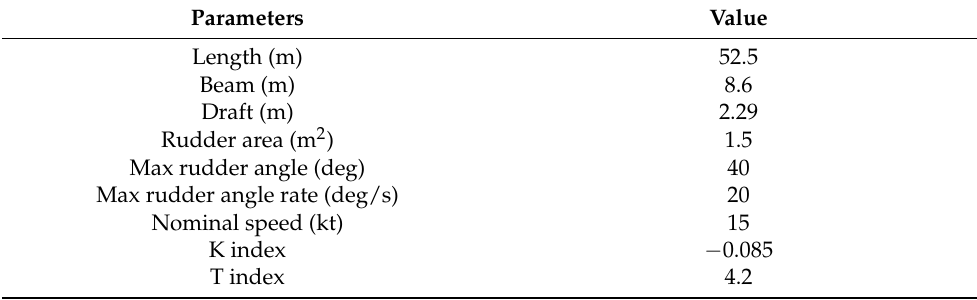
Table 2. Principal dimensions of the ship.